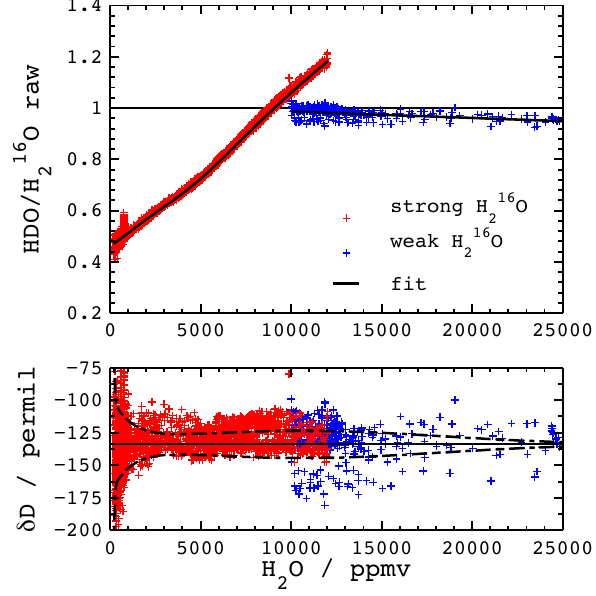
Figure 3. (a) Individual calibration measurements on 25 July 2013 pre- and post-flight together with the daily average calibration functions for strong (red) and weak (blue) H 16 O line fit. (b) Calibration measurements on VSMOW scale corrected for nonlinear response. Dashed lines indicate the 1 σ confidence band.